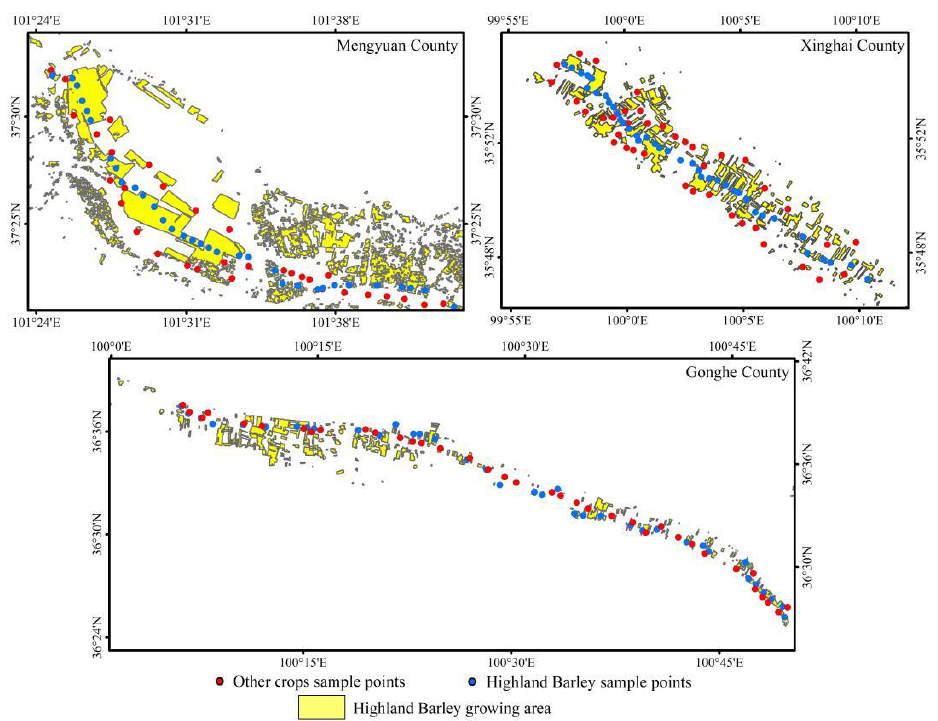
Figure 4. The location of the sample points in QG/FPD.